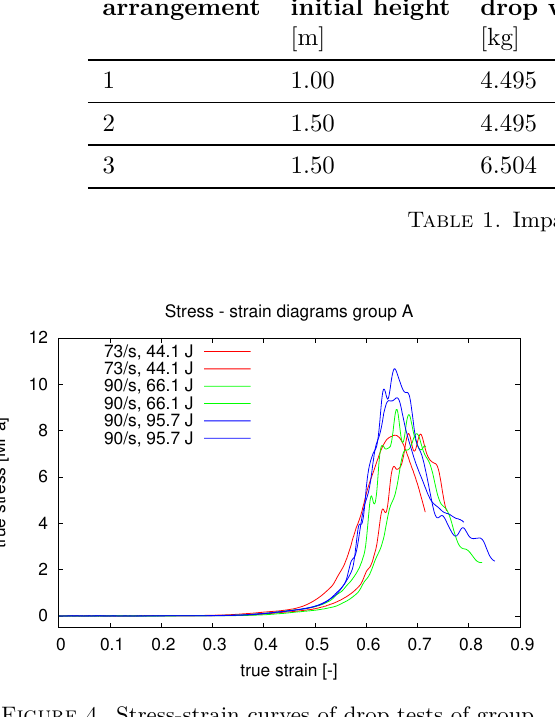
Figure 4. Stress-strain curves of drop tests of group A (ordnance gelatine).